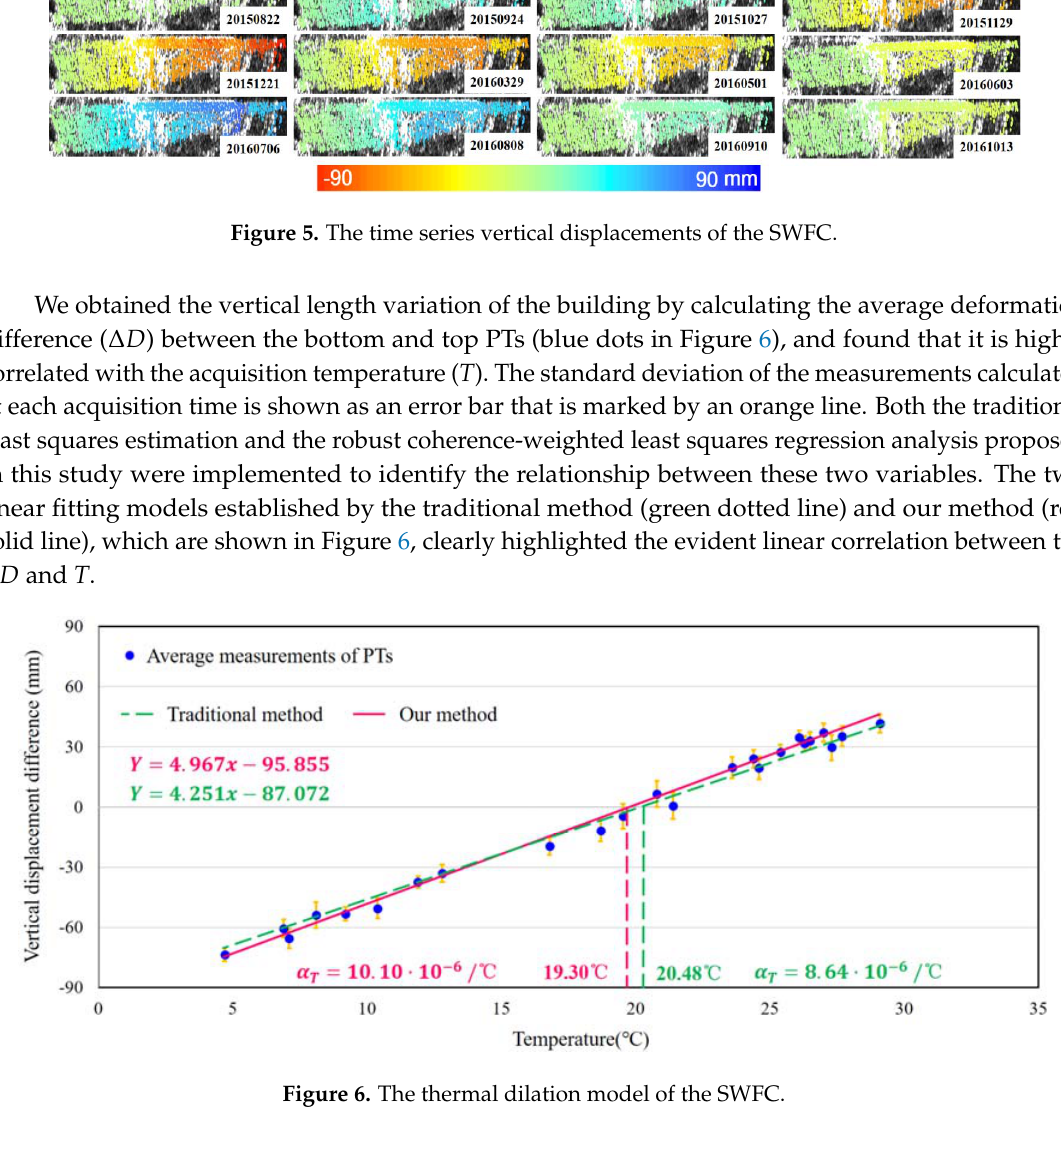
Figure 6. The thermal dilation model of the SWFC.